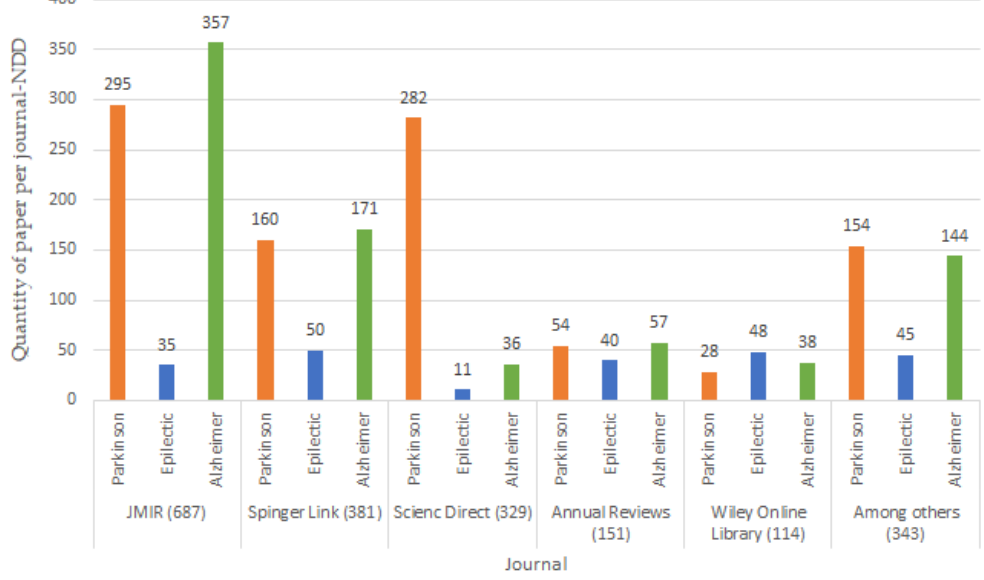
Figure 3. Research papers by digital libraries.